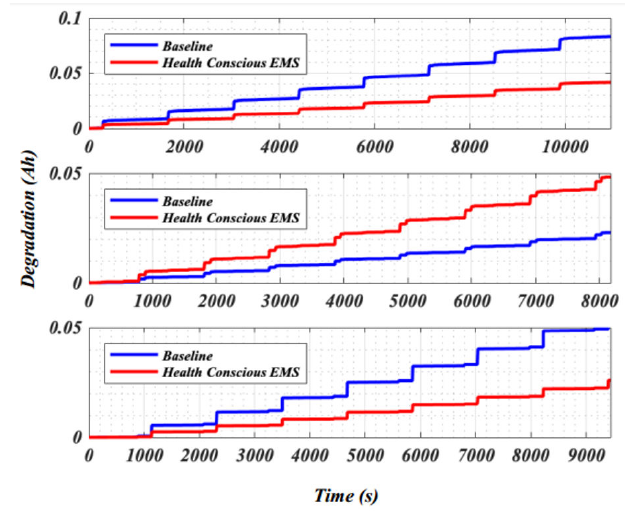
Figure 10. Degradation